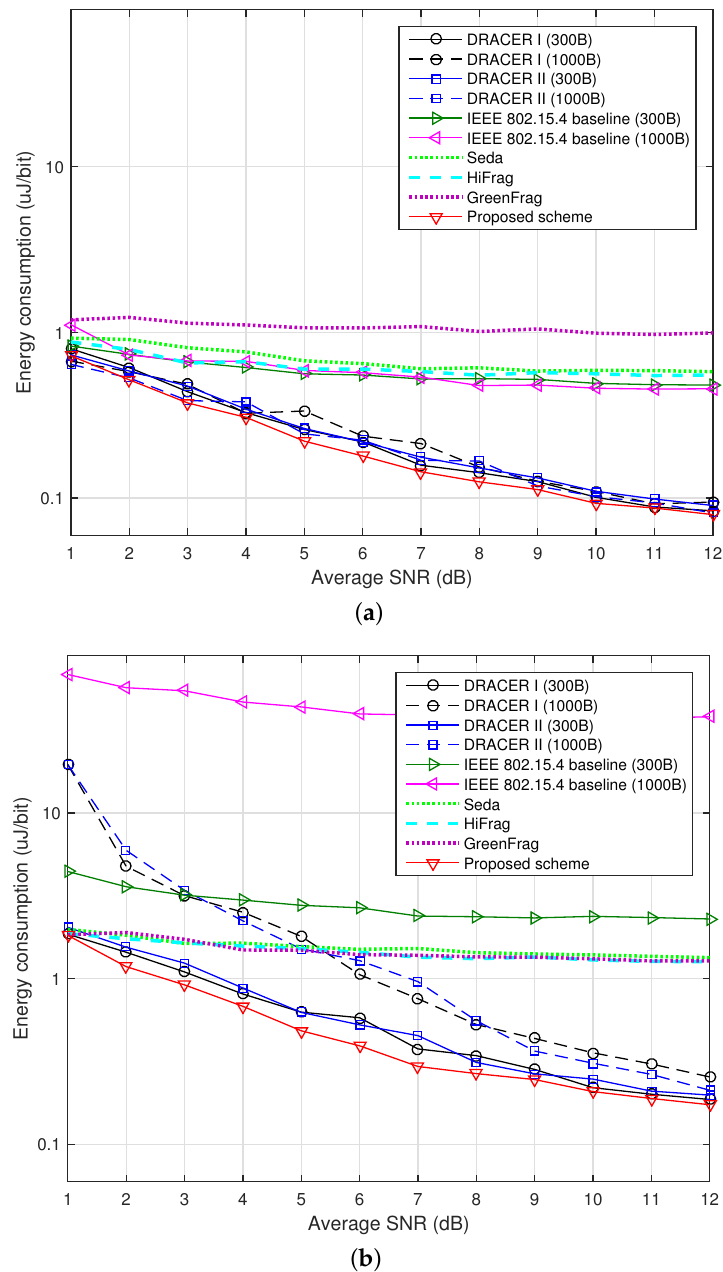
Figure 9. Energy consumption according to the SNR. ( a ) When ρ = 0; ( b ) When ρ =